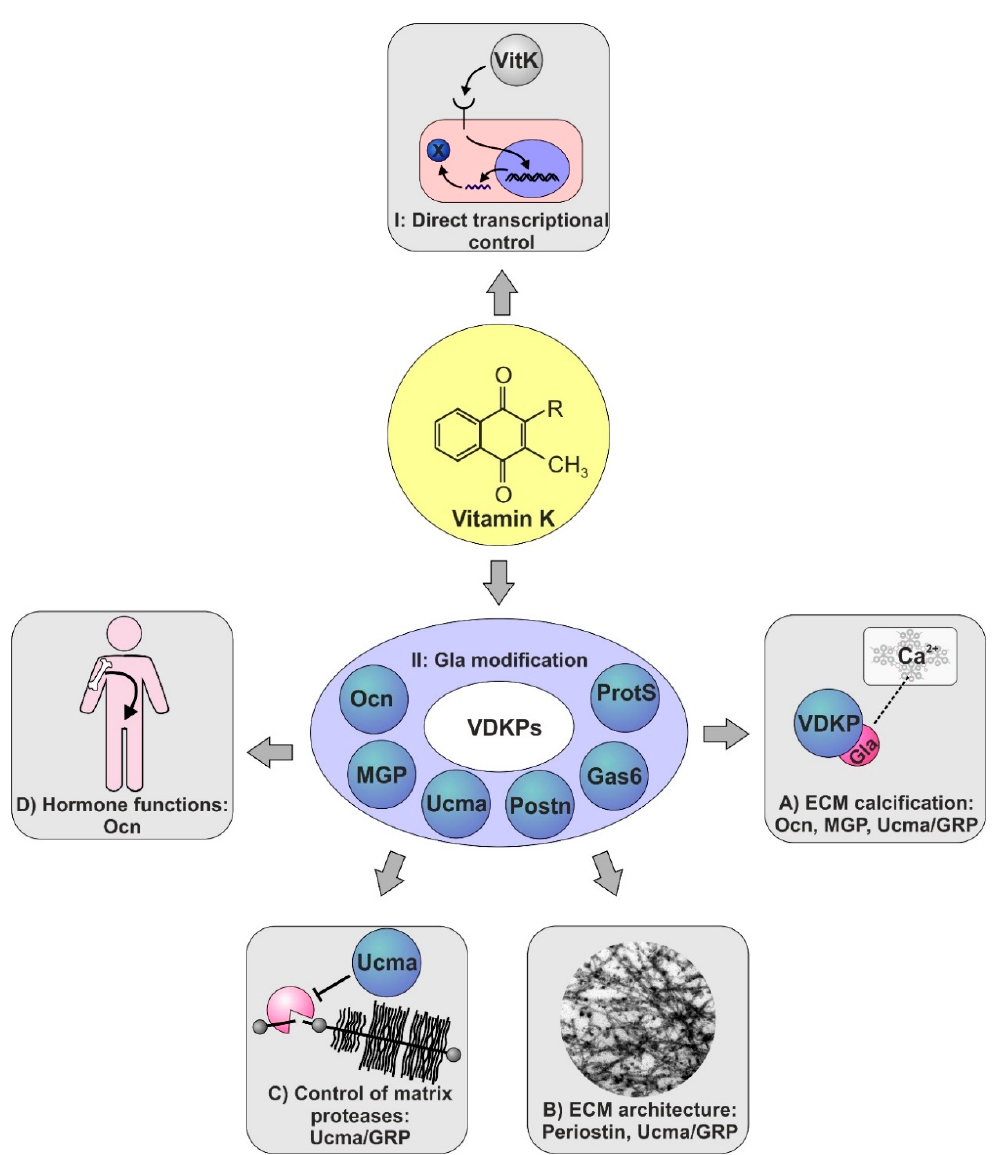
Figure 2. Vitamin K-dependent pathways in skeletal biology. Vitamin K applies multiple molecular pathways in order to affect skeletal biology: I.: Vitamin K may affect cartilage and bone by binding to cell surface receptors, such as the pregnane X receptor. This results in the modulation of downstream signaling pathways ultimately modifying gene expression (e.g., of Msx2). II.: Vitamin K may exert actions on skeletal tissues by acting as a co-factor in the γ -carboxylation of VKDPs. VDKPs, in turn, apply further pathways to affect cartilage and bone biology: ( A ) Through their Gla-residues VKDPs can bind to calcium crystals and thereby modulate calcification processes in bone and soft tissues. This has been particularly investigated for osteocalcin, MGP, and Ucma. ( B ) The second mode of action of VKDPs is the interaction with extracellular matrix proteins, supporting the organization of the ultrastructural matrix architecture (shown, e.g., for periostin and suspected for Ucma/GRP). ( C ) Inhibition of matrix proteases has been shown for Ucma/Grp and mediates a protective effect of Ucma/GRP against cartilage matrix degradation. ( D ) Finally, hormone-like effects of osteocalcin have been shown to mediate crosstalk between bone and glucose metabolism. ECM: extracellular matrix; Postn: periostin; ProtS: protein S; VitK: Vitamin K; X: downstream target gene/protein of Vitamin